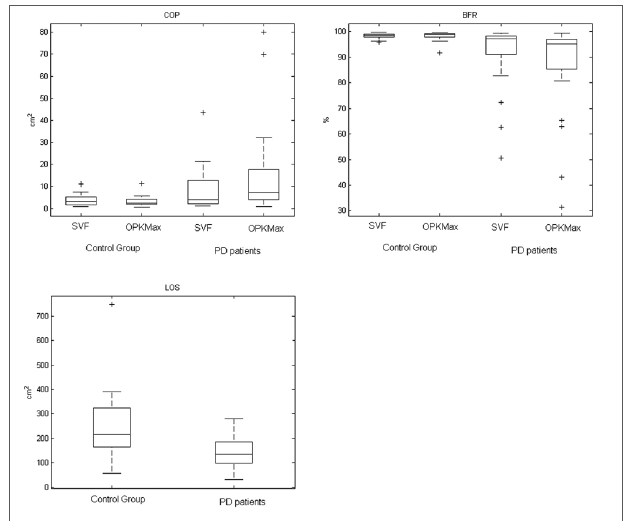
Figure 4. Box plot of the COP of both groups with SVF and OK conditions (Upper left). Box plot of the BFR in the same groups and conditions (Upper right). Box plot of the LOS comparing the CG and PD patients (Lower right).